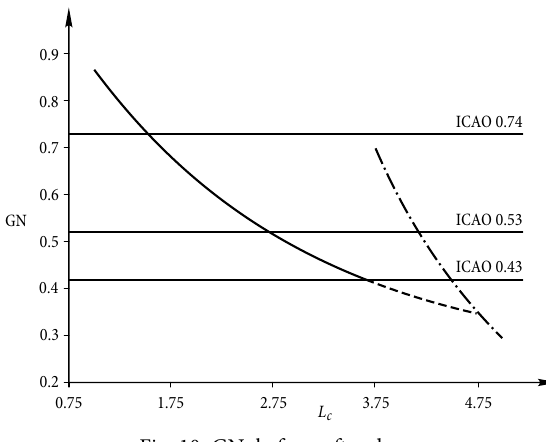
Fig. 10. GN: before–after